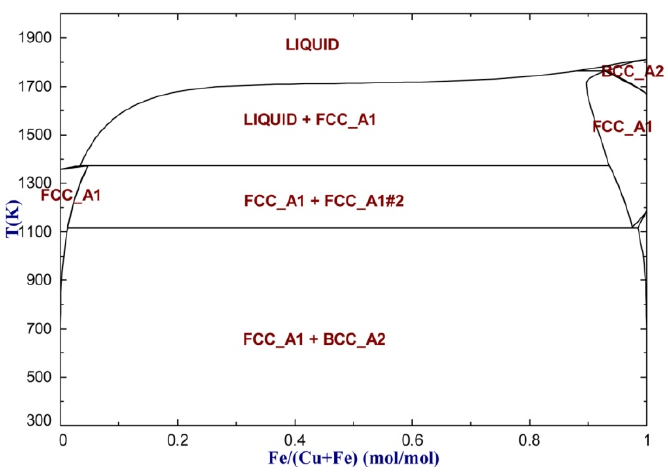
Figure 3. Cu-Fe phase diagram (FactSage 7.3).